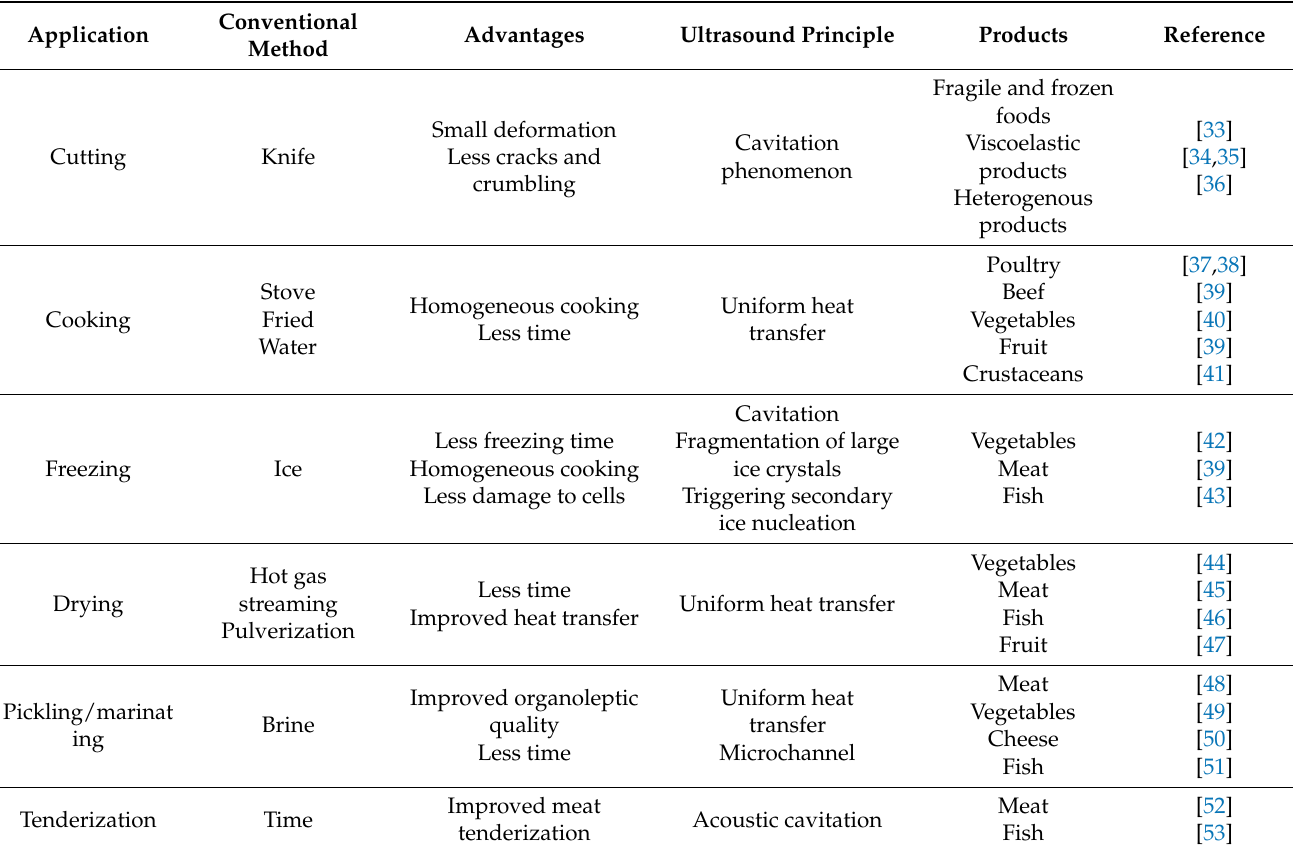
Table 1. Use of ultrasound in food industry: mechanisms, advantages,